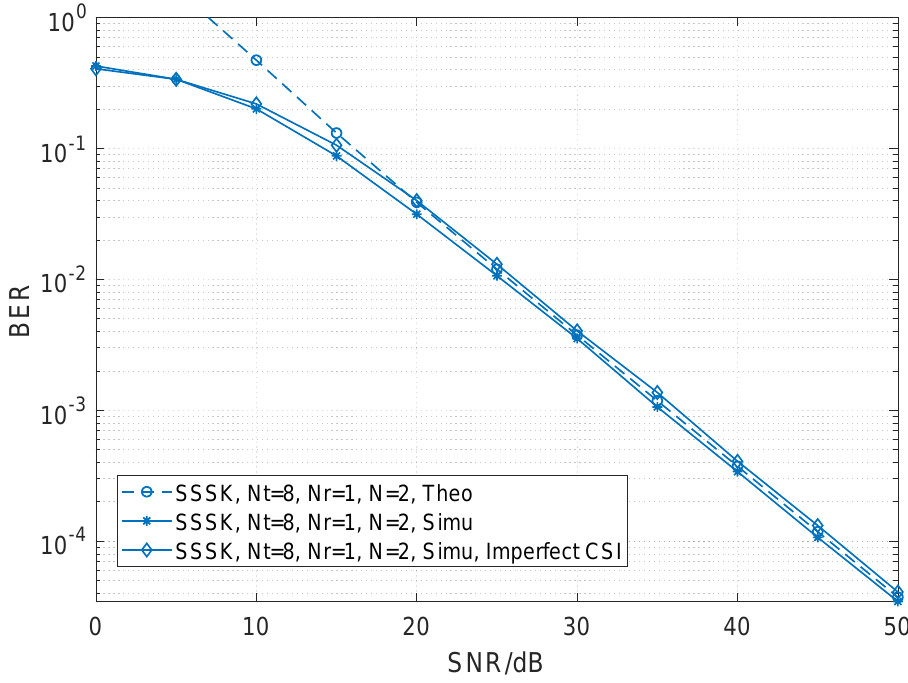
Figure 4. Performance comparisons between the sparse SSK for N = 2 and conventional SSK having N t = 8 and N r = 1 at 2